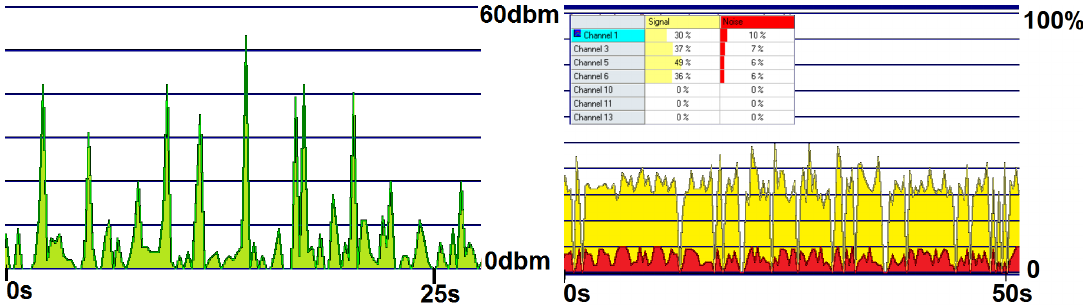
Figure 11. ( a ) Interference score (in dBm) recorded over 25 s on the channel at 2.412 GHz (AirMagnet WiFi Analyzer Limited Edition). ( b ) Screen-shot of signal and noise (as a percentage) recorded over 50 s (AirMagnet WiFi Analyzer Limited